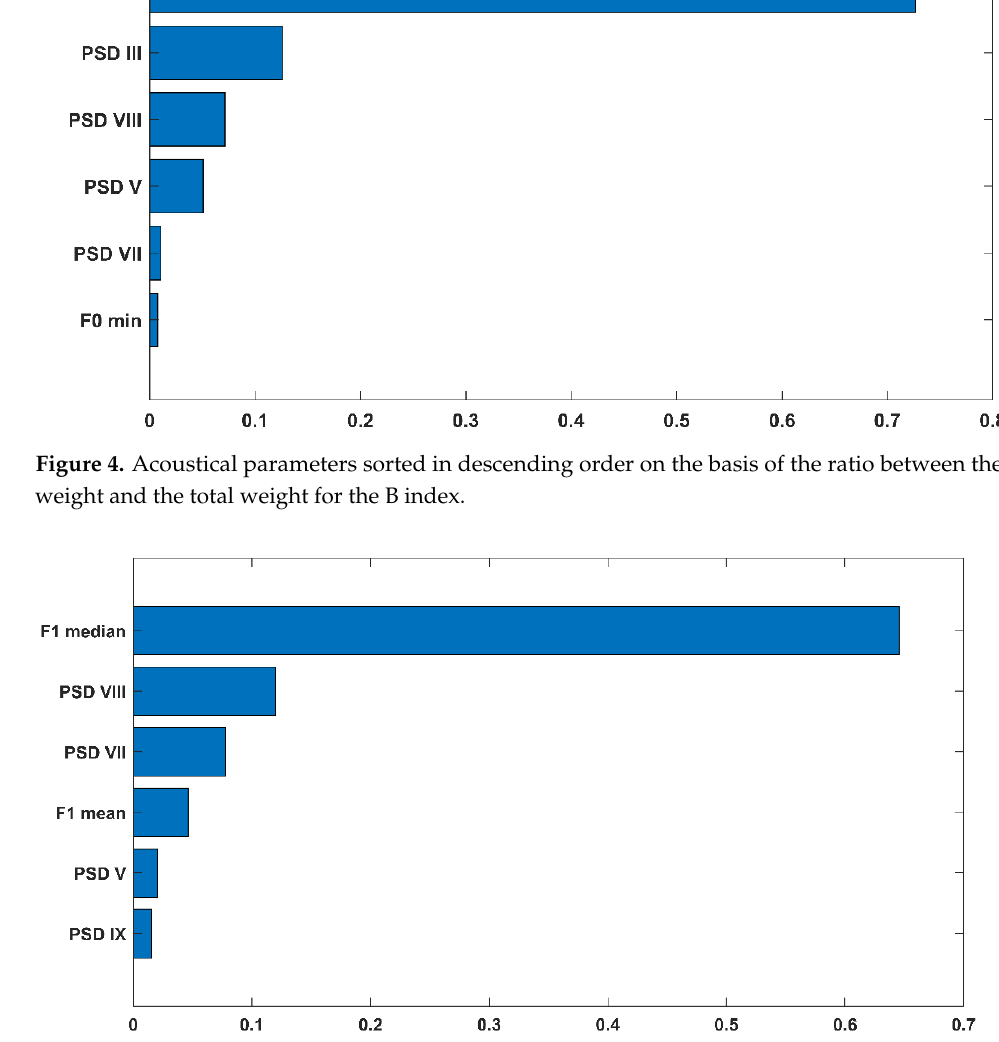
Figure 5. Acoustical parameters sorted in descending order on the basis of the ratio between their weight and the total weight for the Spasmodicity index.